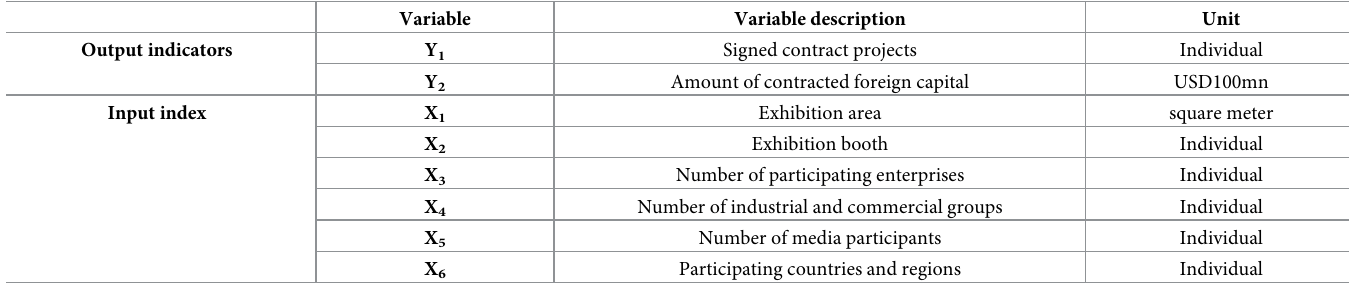
Table 1. Allocation efficiency index system of